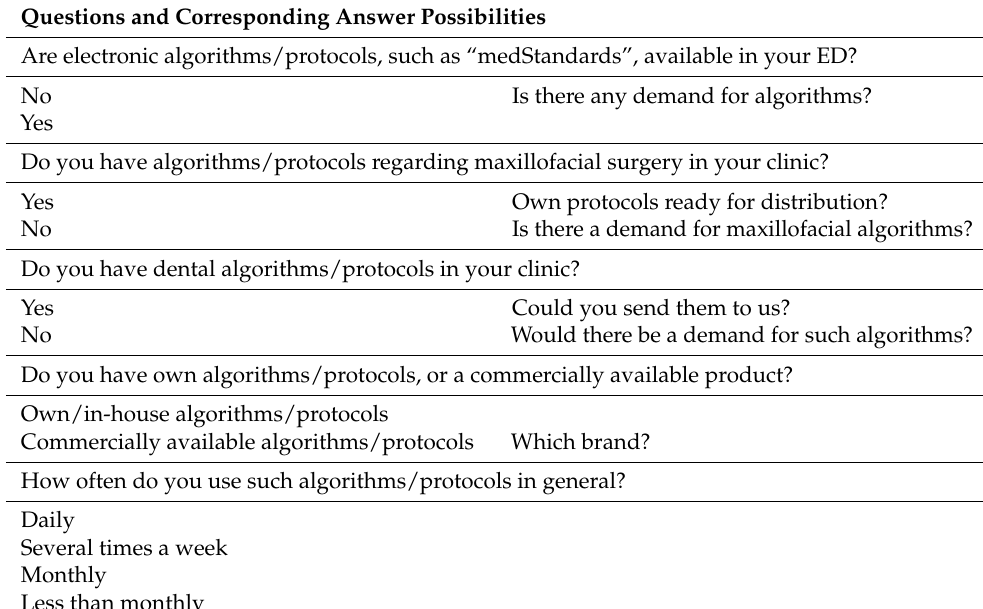
Table 1. Telephone survey among doctors in Swiss emergency departments (ED). Questions and Corresponding Answer Possibilities